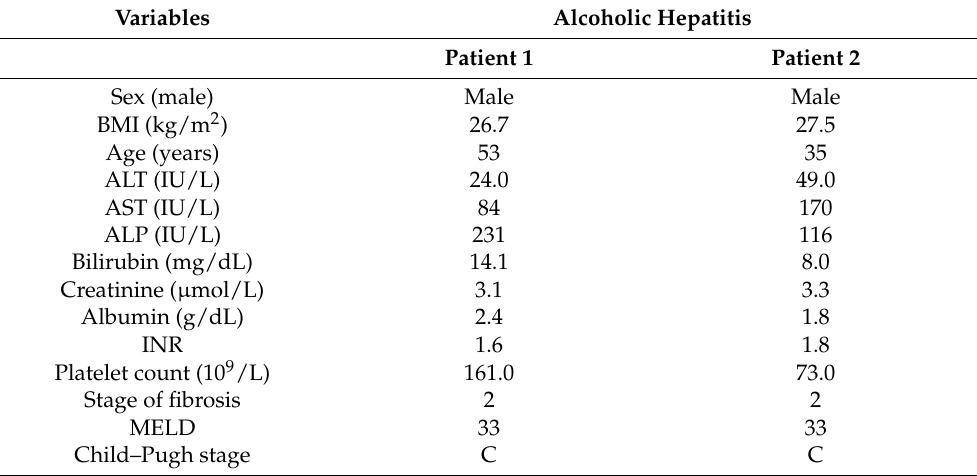
Table 1. Characteristics of patients with alcoholic hepatitis used as stool donors for germ-free